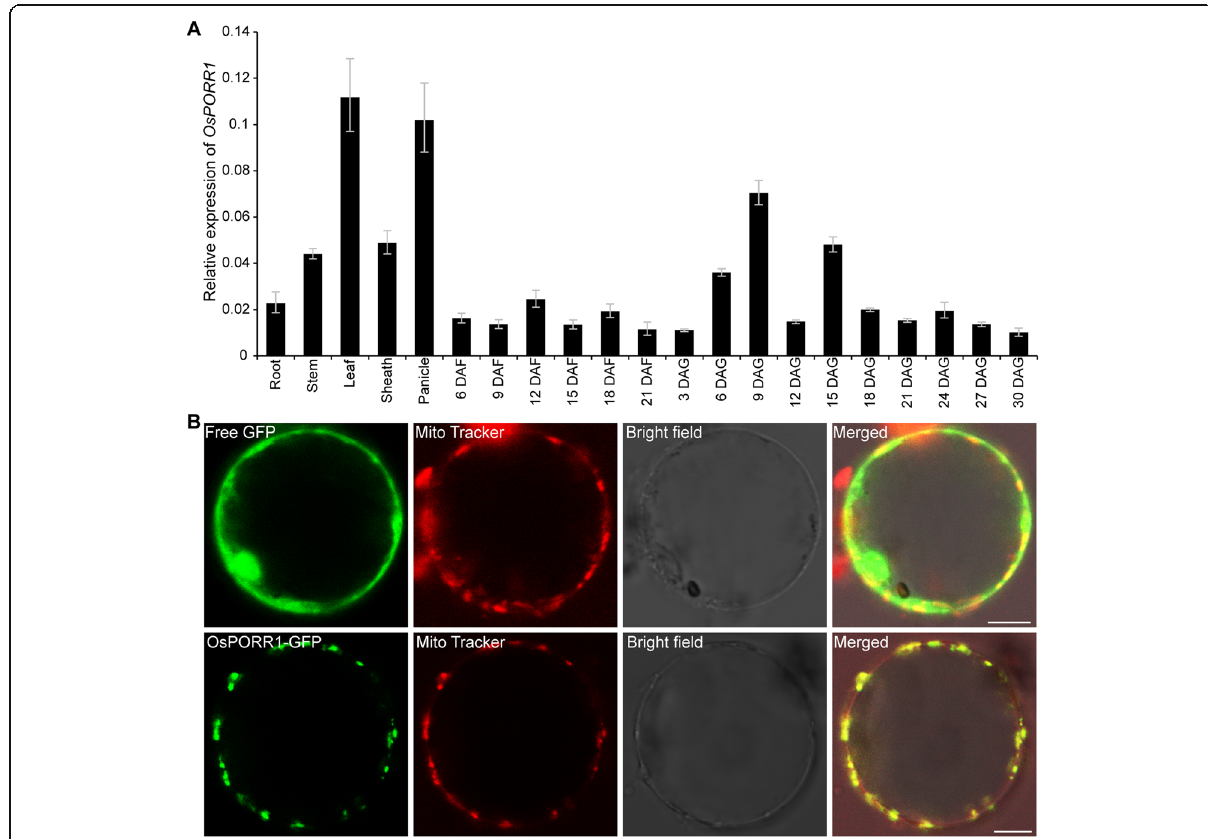
Fig. 5 Spatiotemporal expression and subcellular localization of OsPORR1. a Expression of OsPORR1 in various plant organs, developing seeds and seedlings at different times. DAG, days after germination. Three biological replicates were subjected to qRT-PCR. OsActin1 was used as an internal control for data normalization. The values are the means ± SDs. b Subcellular localization of OsPORR1. GFP served as a control. GFP signals in protoplasts isolated from positive transgenic seedlings were observed via confocal laser scanning microscopy. Mito Tracker Orange was used to identify mitochondria. Bars, 10 μ